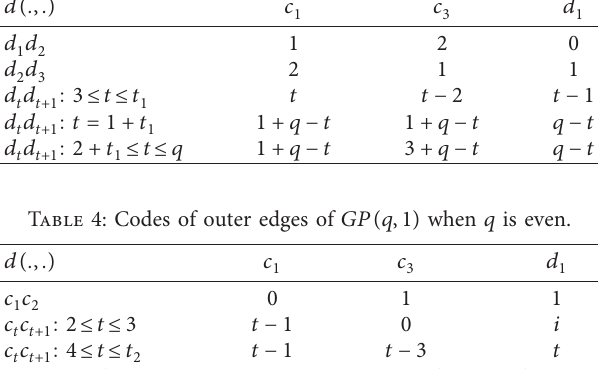
Table 3: Codes of inner edges of GP ( q, 1 ) when q is odd. d ( ., . )